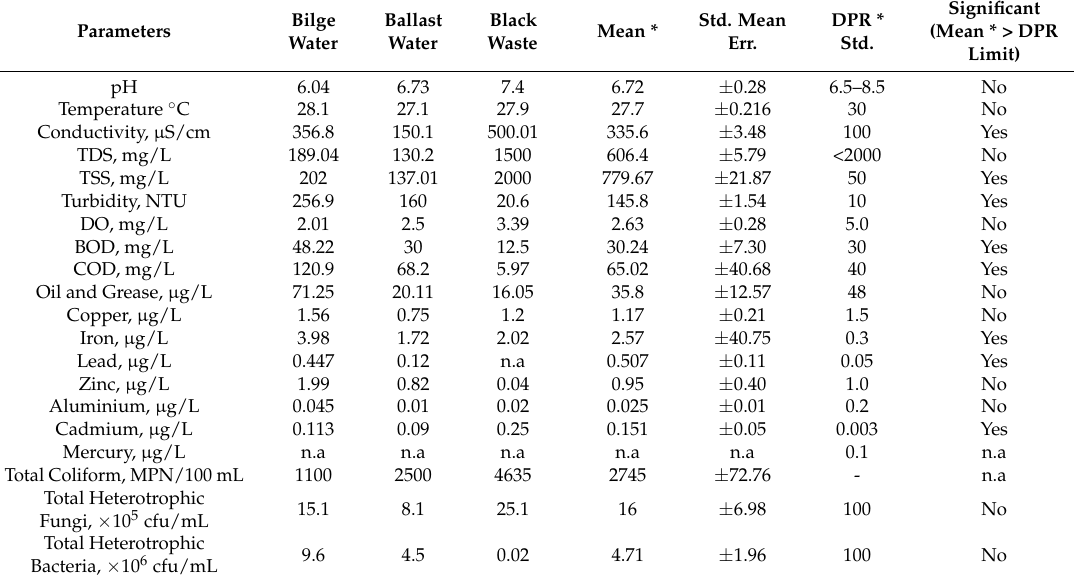
Figure 5. Distribution of the microbiological parameters of shipborne wastewater. Figure 6. Distribution of the microbiological parameters of shipborne wastewater. Table 2. Descriptive Statistics and Comparison of the Physico-chemical and Microbiological Parameters Obtained from the Department of Petroleum Resources (DPR) Nigeria, Specified